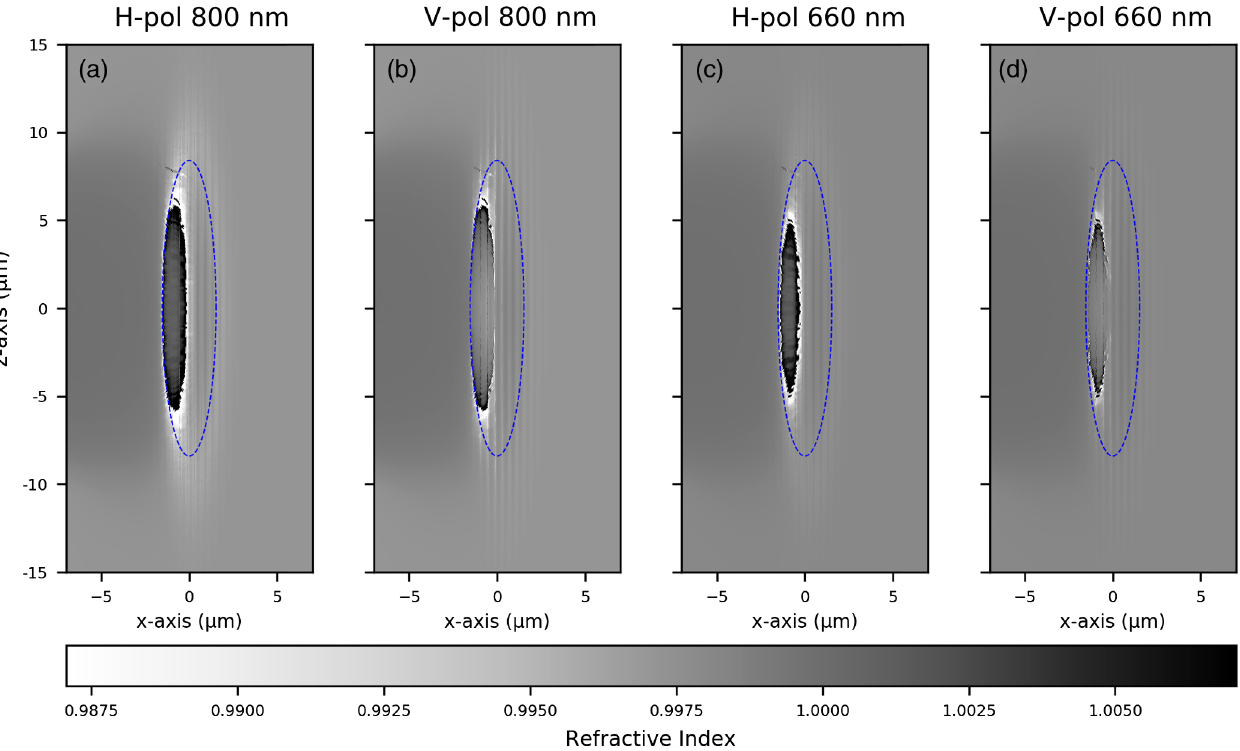
FIG. 9. Refractive index of the plasma in the xz plane for different probe polarizations and wavelengths induced by a pump pulse with a 6.0 fs FWHM duration and an a 0 of 5.0. The blue, dashed line represents the 1 = e 2 intensity contour of the Gaussian pump pulse. Each subplot of the figure is labeled with the probe beam ’ s polarization (H-pol or V-pol) and its wavelength (800 or 660 nm). The figures are calculated from data produced from VS im in simulating the xz